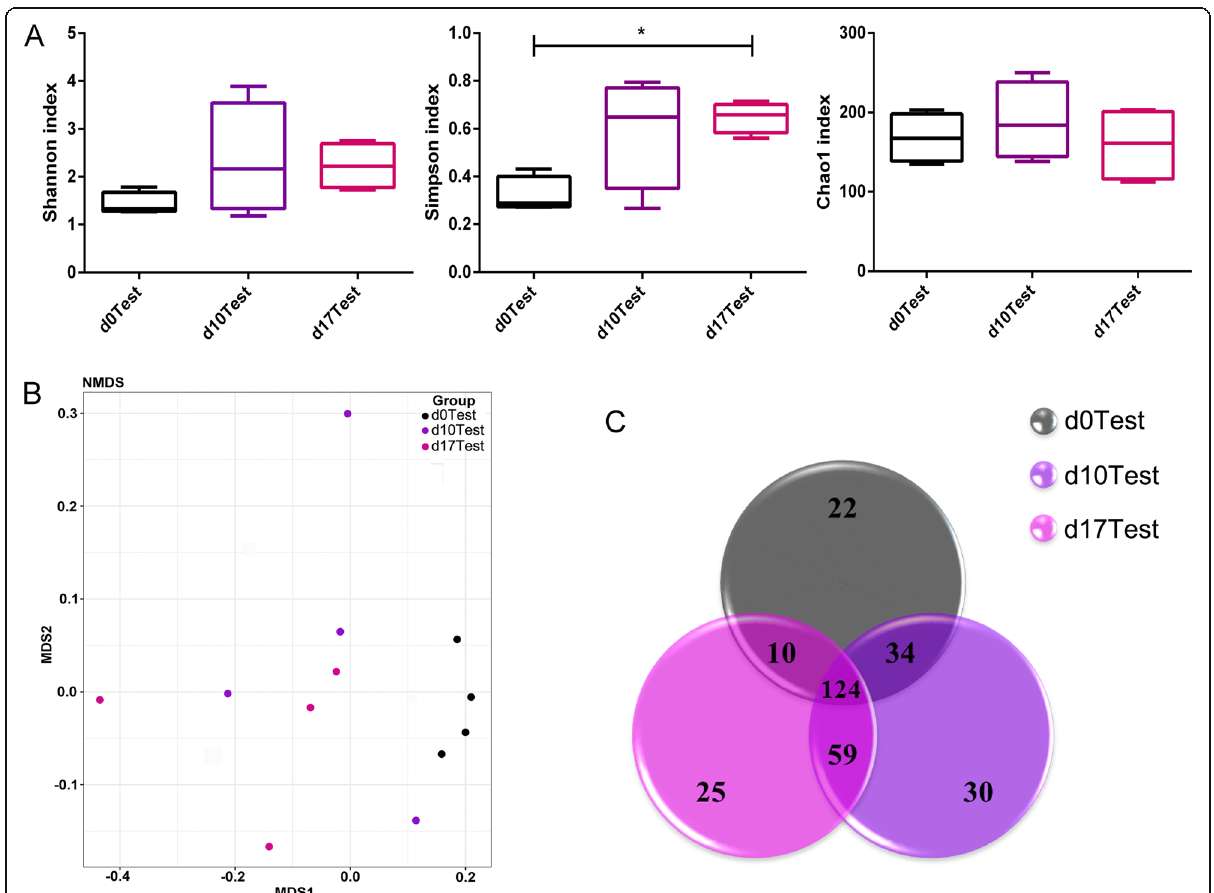
Fig. 3 Changes in the characteristics of gut microbiota in exposed rats in the course of pregnancy. a The alpha-diversity of gut microbiome revealed by Shannon, Simpson, and Chao1 index. b The beta-diversity was revealed by NMDS analysis. c The unique and sharing OTUs numbers were presented in Venn diagram. D0 Test means samples collected from rats before exposure to TiO 2 NPs, d10 Test, and d17 Test means samples collected from exposed rats at GD 10 and GD 17,